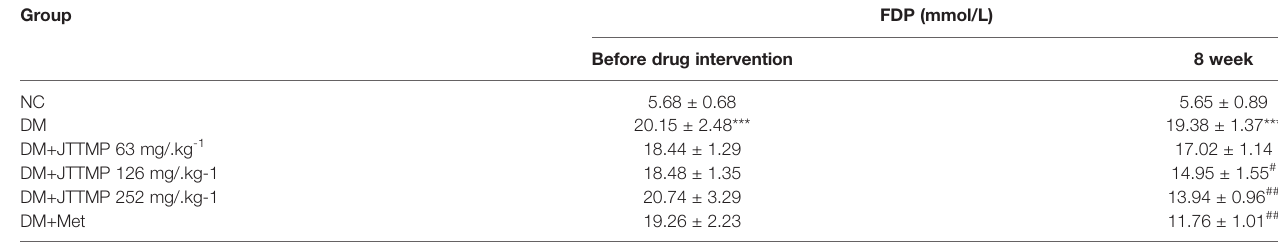
TABLE 2 | Comparison of FPG among the different groups ( (cid:1) x ± s, n=6). Group